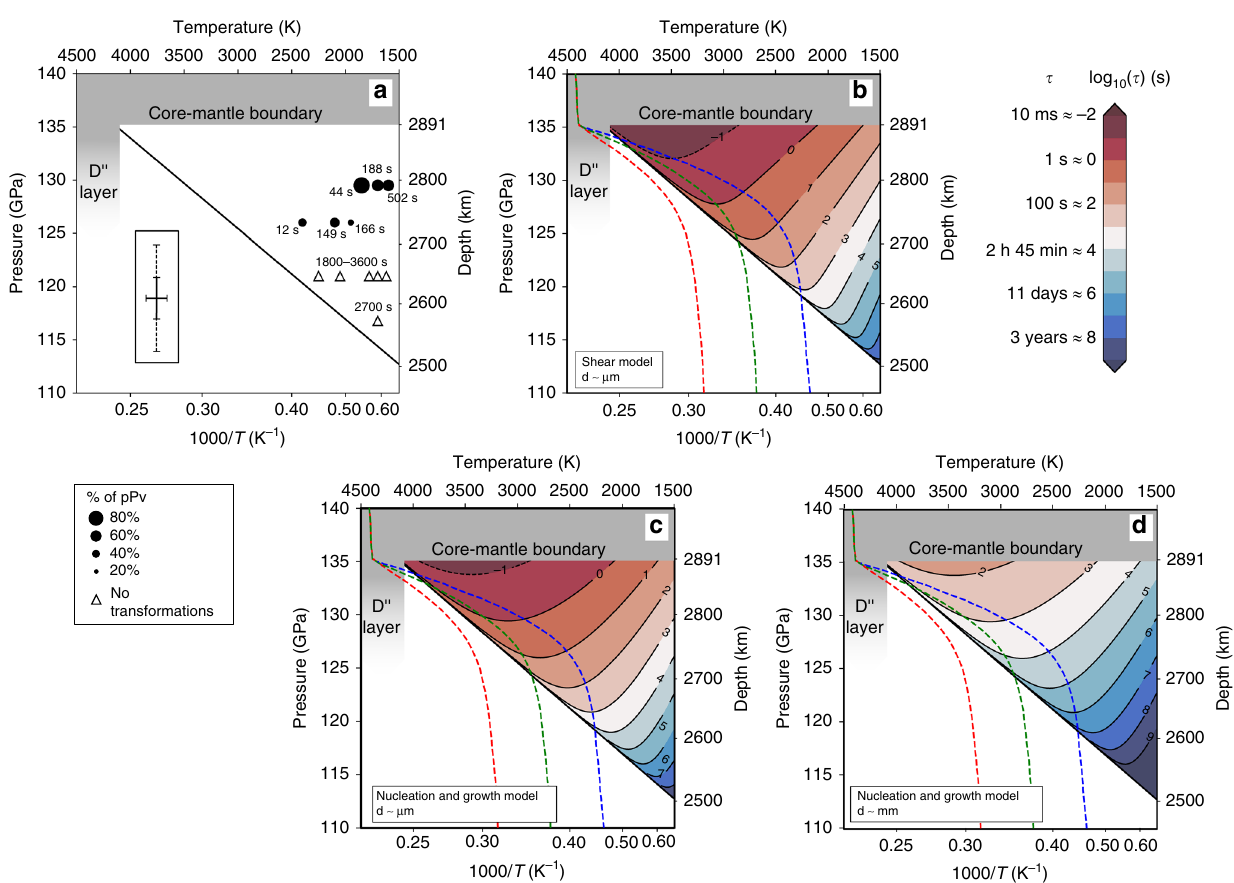
Fig. 3 Models of bridgmanite transformation kinetics in D ″ . a Transformation characteristic times τ measured in the experiments vs. P and T. The fi gure also indicates the fi nal weight proportions of pPv by the size of the symbol. Solid line: reference for the Pv/pPv phase boundary (de fi ned by a reference point at P ¼ 128 GPa, T ¼ 3300 K, and a Clapeyron slope of 8.5 MPa K (cid:3) 1 ). Inset: ± 1 σ uncertainties on P and T . Solid and dashed lines represent relative and absolute uncertainties on P , respectively. b – d Extrapolated transformation characteristic times vs. P and T for the shear ( b ) or nucleation and growth ( c , d ) phase transformations models. Red, green, and blue dashed lines are the hot, warm and cold geotherms of ref. 5 . The shear transformation model is independent of grain size. d Extrapolation of the nucleation and growth model to mm grain